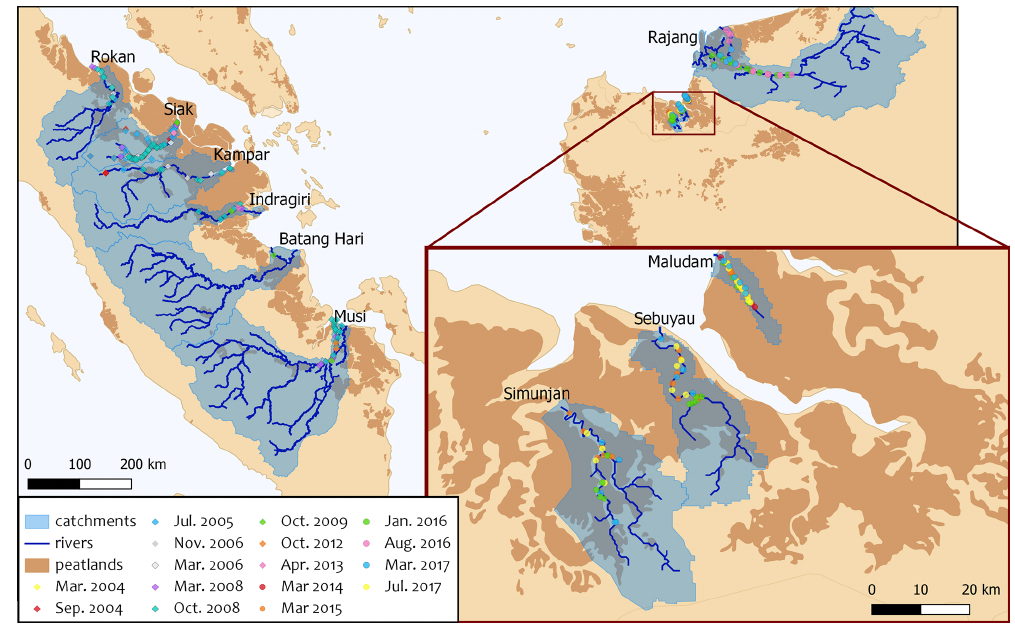
Figure 1. Map of river catchments with the location of peat areas. Blue lines indicate the main rivers. Blue shaded areas outline the river basins, and brown areas indicate peatlands. Coloured data points indicate the sampling stations of the individual